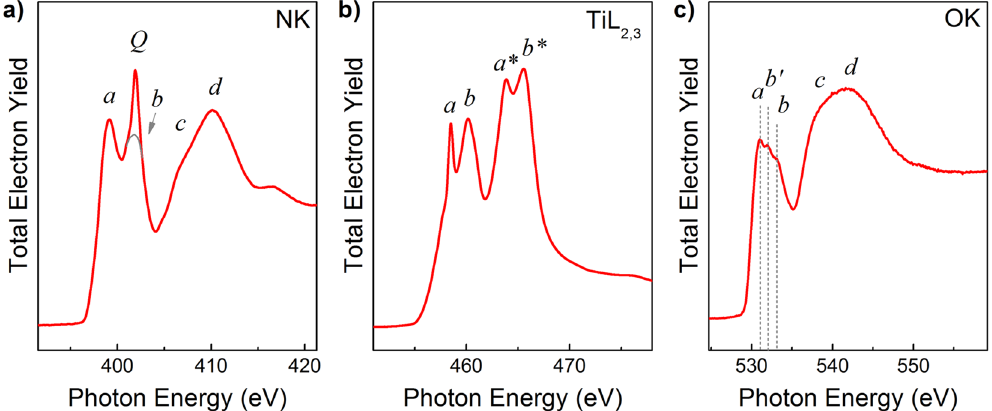
Figure 7. Absorption spectra of the TiN/ γ -Al 2 O 3 /Si stack measured through the TiN electrode in the vicinity of ( a ) K- absorption edge of nitrogen; ( b ) L 2,3 - absorption edge of titanium; ( c ) K- absorption edge of oxygen. The grey curve at panel ( a ) shows the model NK-absorption spectrum without contribution of molecular nitrogen peak (i.e., without peak Q ). The spectra were obtained by monitoring the total electron yield by measuring drain current from the sample at the incident angle of 45° using s-polarized synchrotron radiation. All the spectra were normalized to the continuum jump after subtraction of linear background extrapolated from the energy region below the corresponding absorption